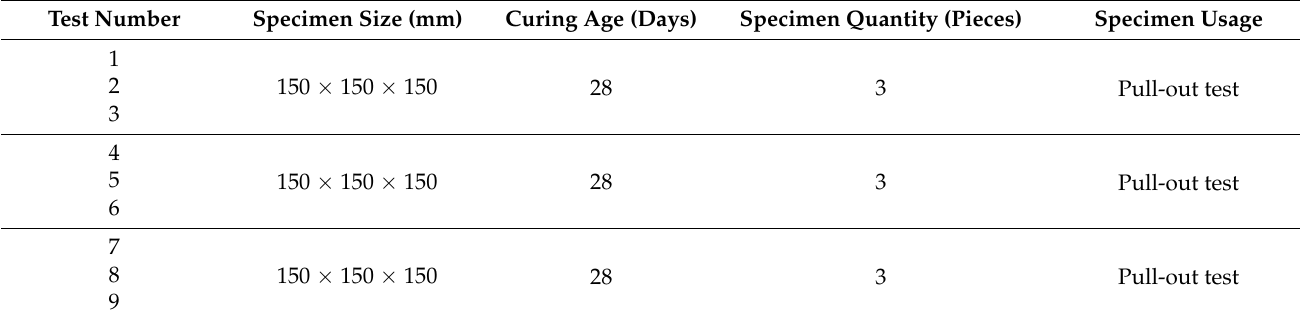
Table 3. Summary of pull-out test